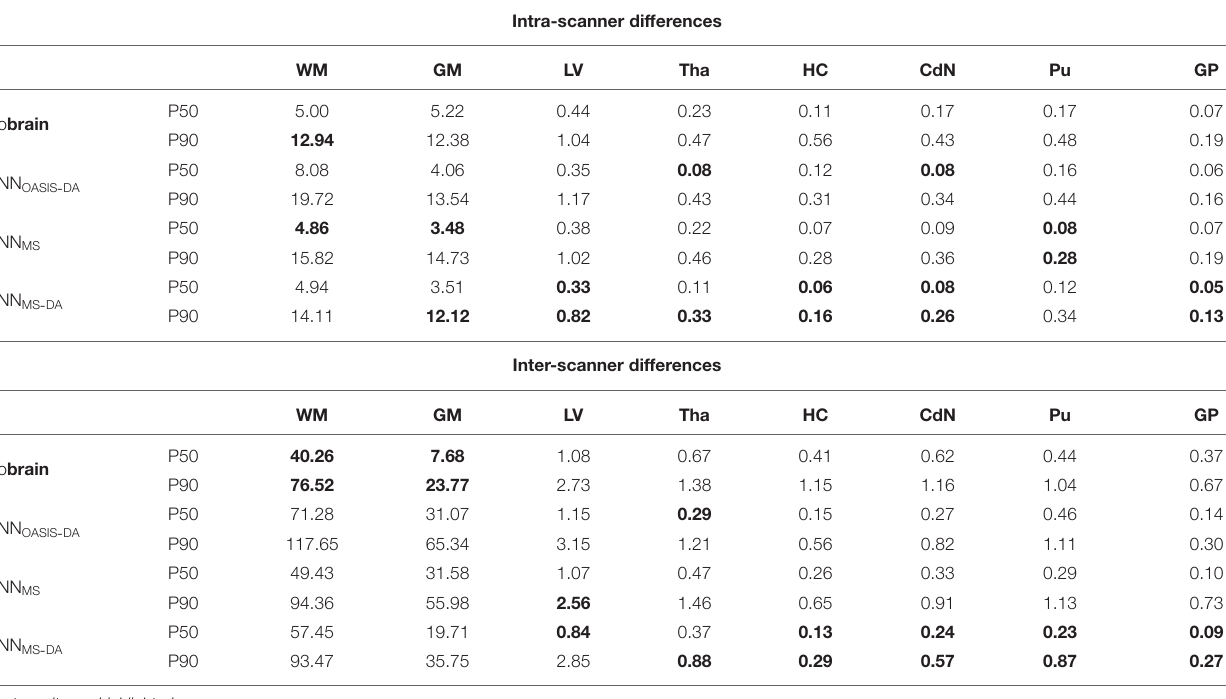
TABLE 4 | Volume differences (mL) between intra- and inter-scanner repetitions from the same patient.